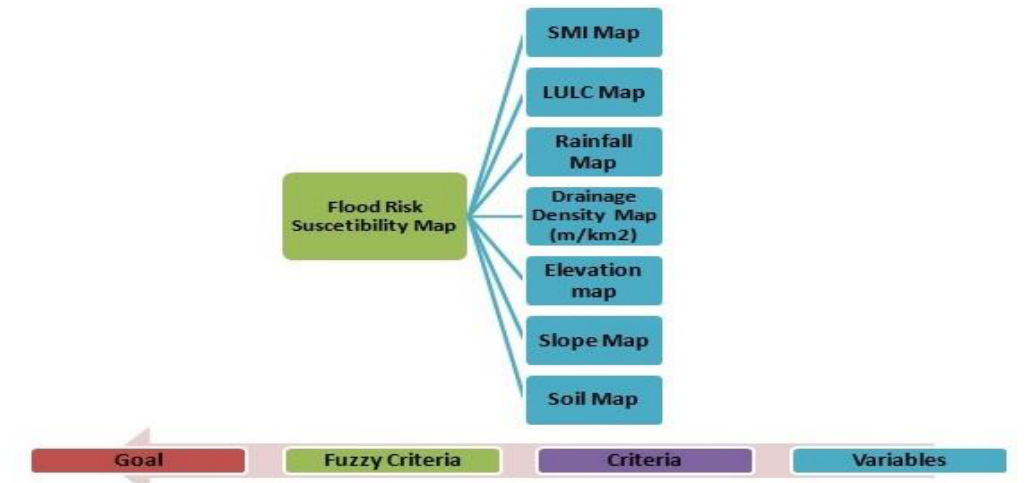
Figure 3. FAHP Analysis Workflow for Flash Flood Susceptibility